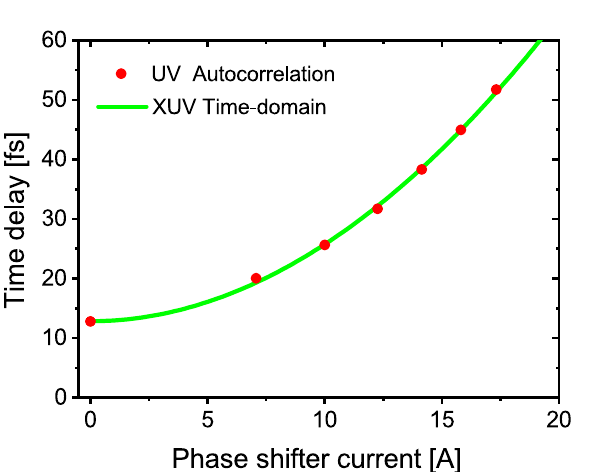
Figure 4. Time-domain Ramsey fringe spectrum. ( a ) The fluorescence yield in the 1 s → 5p excitation of the helium atom was measured as a function of the phase shifter current. The time delay produced by the phase shifter was calibrated using a sinusoidal curve that oscillates at 172 as period corresponding to the resonant frequency of the 1 s → 5p excitation. The time delay converted from the phase shifter current is shown on the top axis. ( b ) Enlarged plots in the three regions indicated by the blue broken lines in ( a ).